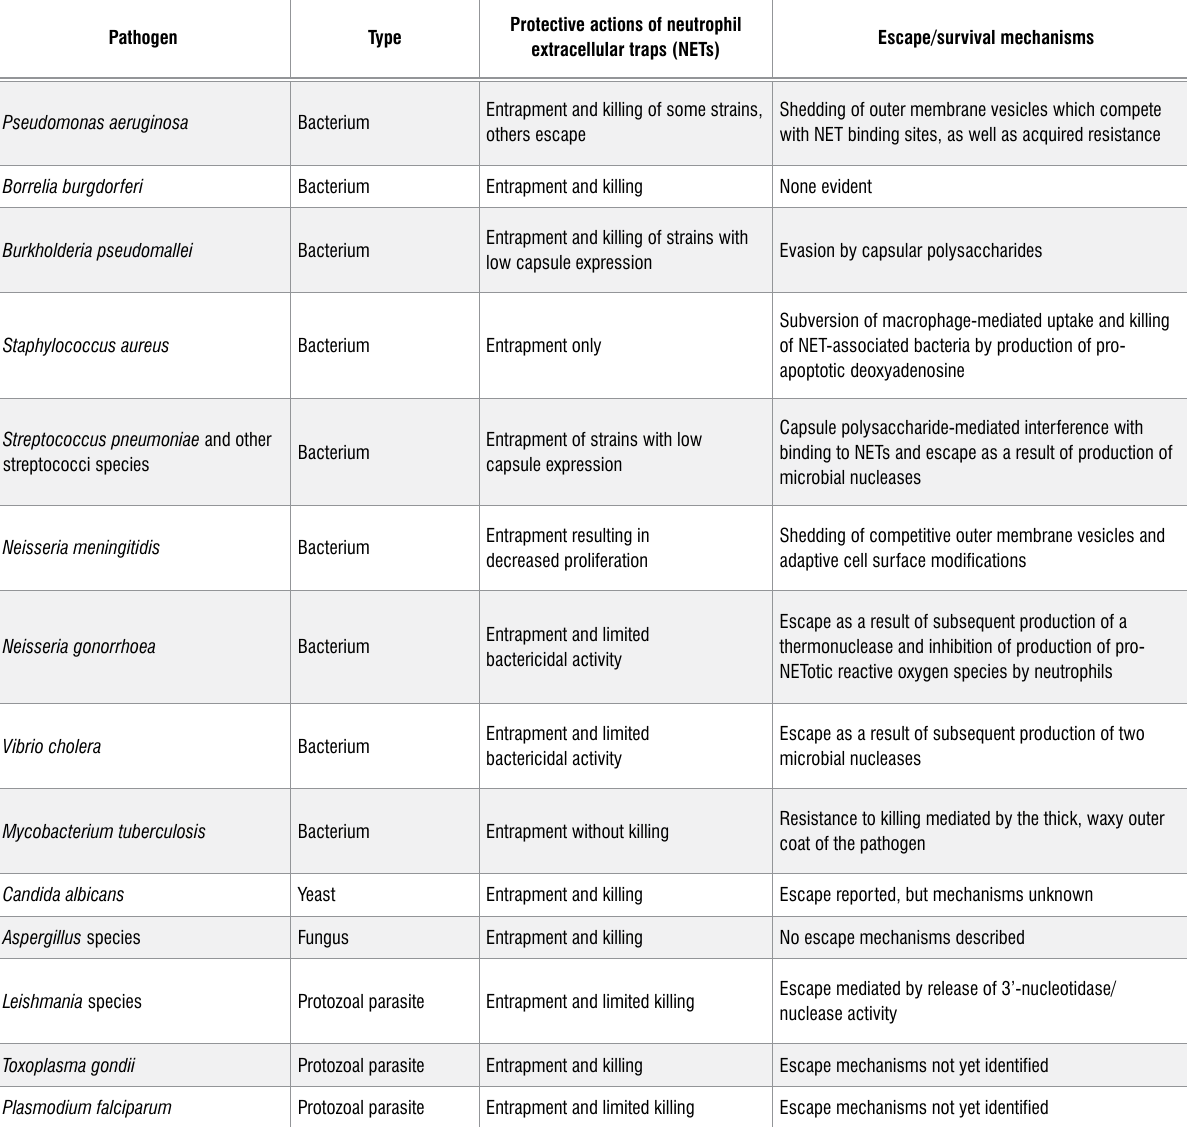
Table 2: Examples of microbial pathogens which induce NETosis and their escape strategies